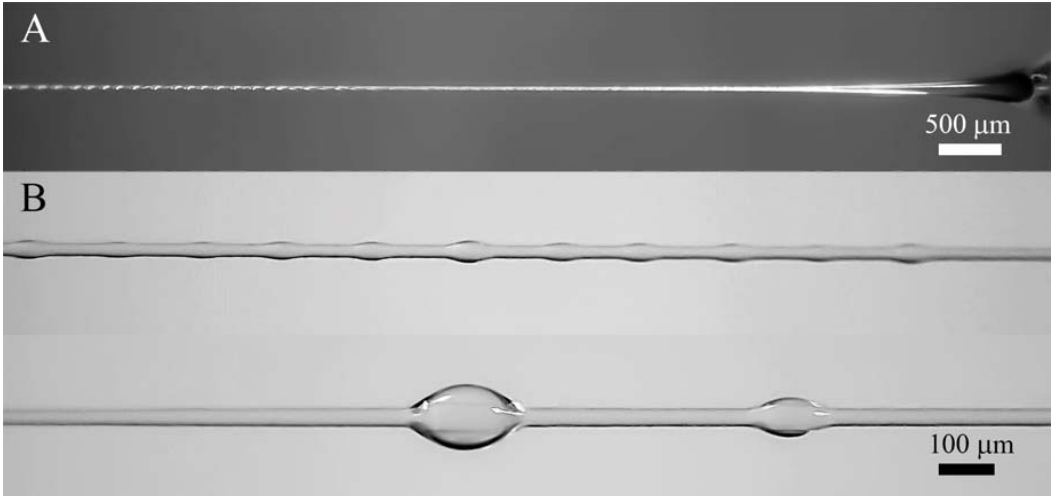
Figure 12. Images of continuous spinning of PAN fibers at different magnification: ( A )—general view; ( B )—enlarged images of the jet section.